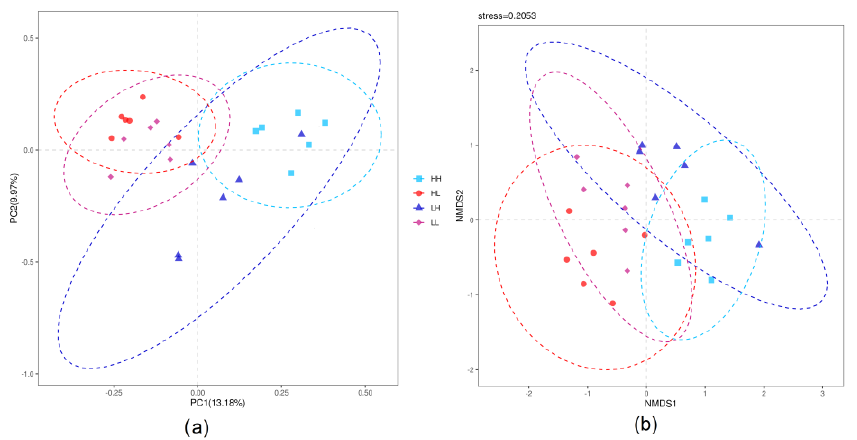
Figure 2. Beta-diversity of the rumen bacteria under four energy provision strategies: ( a ) principal coordinates analysis (PCoA); ( b ) nonmetric multidimensional scaling (NMDS).